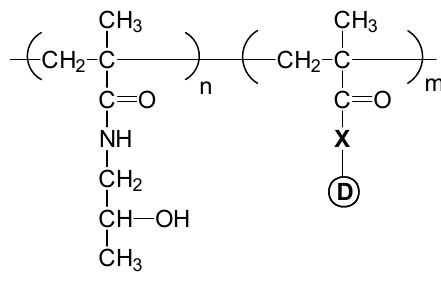
Figure 5 . Chemical structure of HPMA copolymer-drug conjugate. X = peptide link, D =